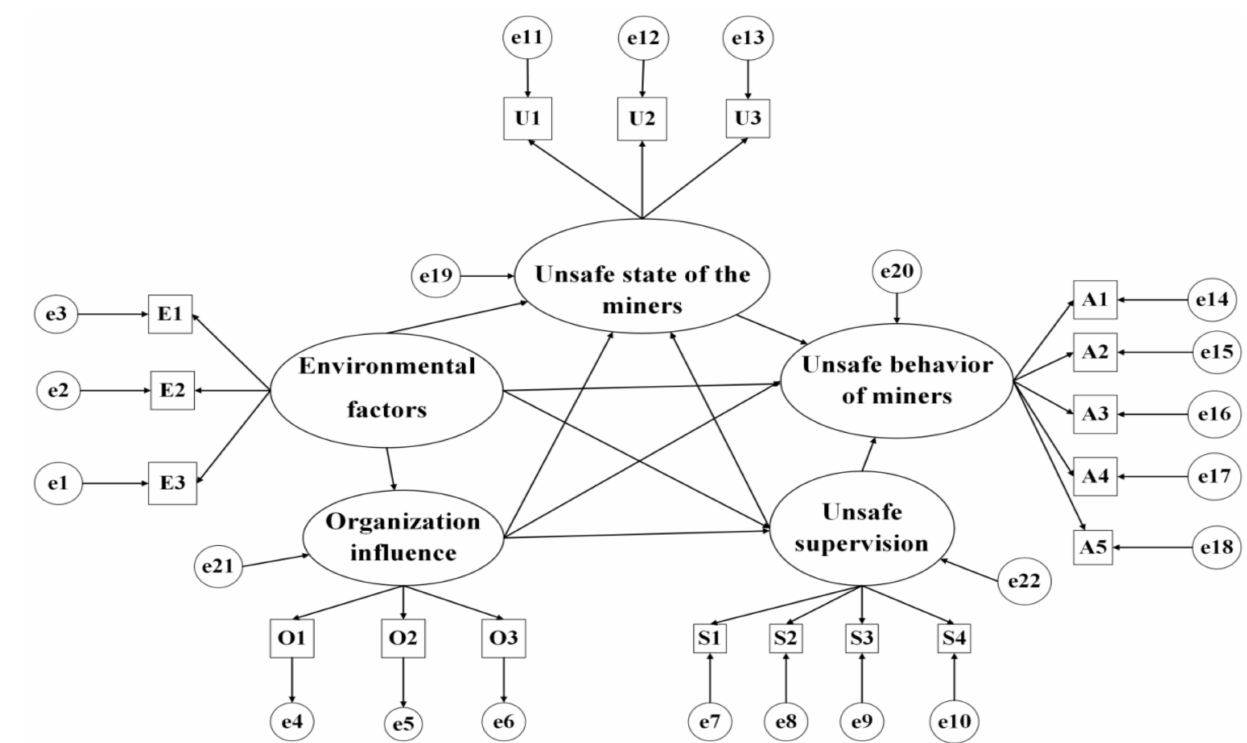
Figure 3. Preliminary SEM of the formation mechanism of unsafe behavior of deep coal